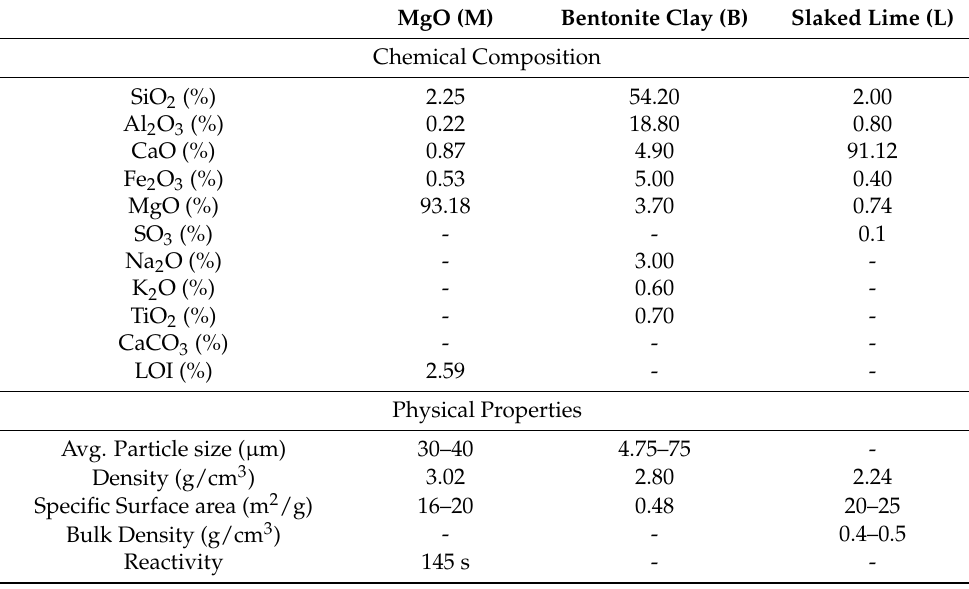
Table 1. Chemical composition and physical characteristics of mineral